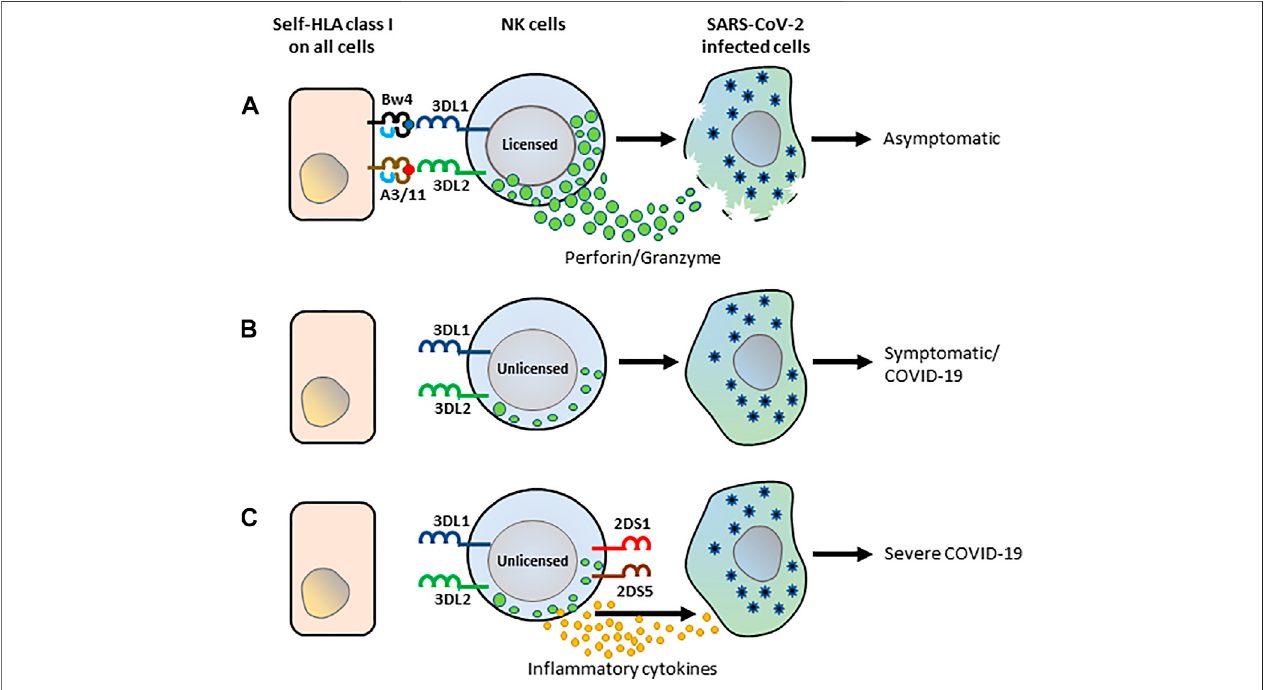
FIGURE 3 | The schematic framework of KIR-HLA interactions by NK cells in anti-SARS-CoV-2 immunity. (A) Interactions of KIR3DL1 and KIR3DL2 with their cognateHLAclassIligands,HLA-Bw4and HLA-A3/11respectively,in fl uenceNKcelllicensingandset ahighthreshold forNKcelllysis.Thelicensed NKcellsrecognize SARS-CoV-2-infected and trigger an antiviral response. (B) The unlicensed NK cells developed from those lacking KIR3DL1+Bw4+ and KIR3DL2+HLA-A3/11 + combinations are hyporesponsive and do not trigger an antiviral response, consequently leading to COVID-19 illness. (C) NK cells of patients lacking KIR3DL1+Bw4+ and KIR3DL2+HLA-A3/11 + combinations but expressing activating KIR2DS1 and 2DS5 presumably triggers abundant cytokines and chemokines arbitrating severe COVID-19.